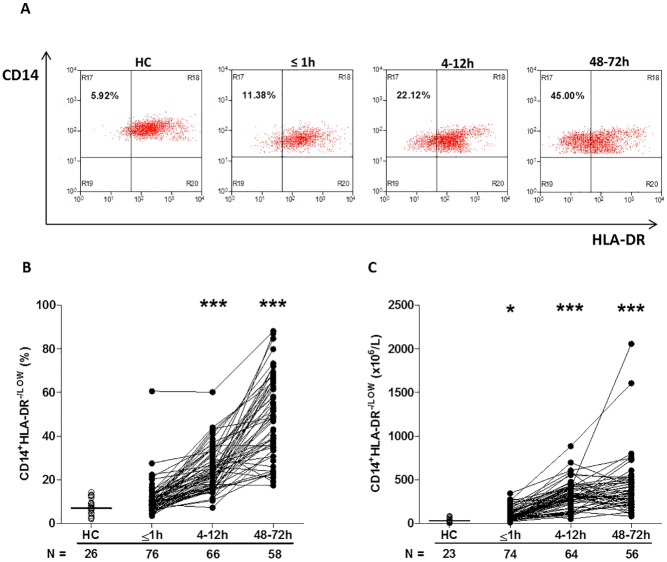
Traumatic injury results in elevated percentages and absolute numbers of circulating CD14+HLA-DR-/low immunosuppressive monocytes.(A) Representative flow cytometry plots depicting the percentage of CD14+HLA-DR-/low monocytes (upper left quadrant) in a single HC and a trauma patient across time. (B–C) Prospective assessment of the percentage (B) and absolute number (C) of CD14+HLA-DR-/low monocytes post-trauma. The number of samples analysed is indicated below each time point. The horizontal line for HC data depicts the median value. *p < 0.05, ***p < 0.0005 versus HC. HC, healthy control.